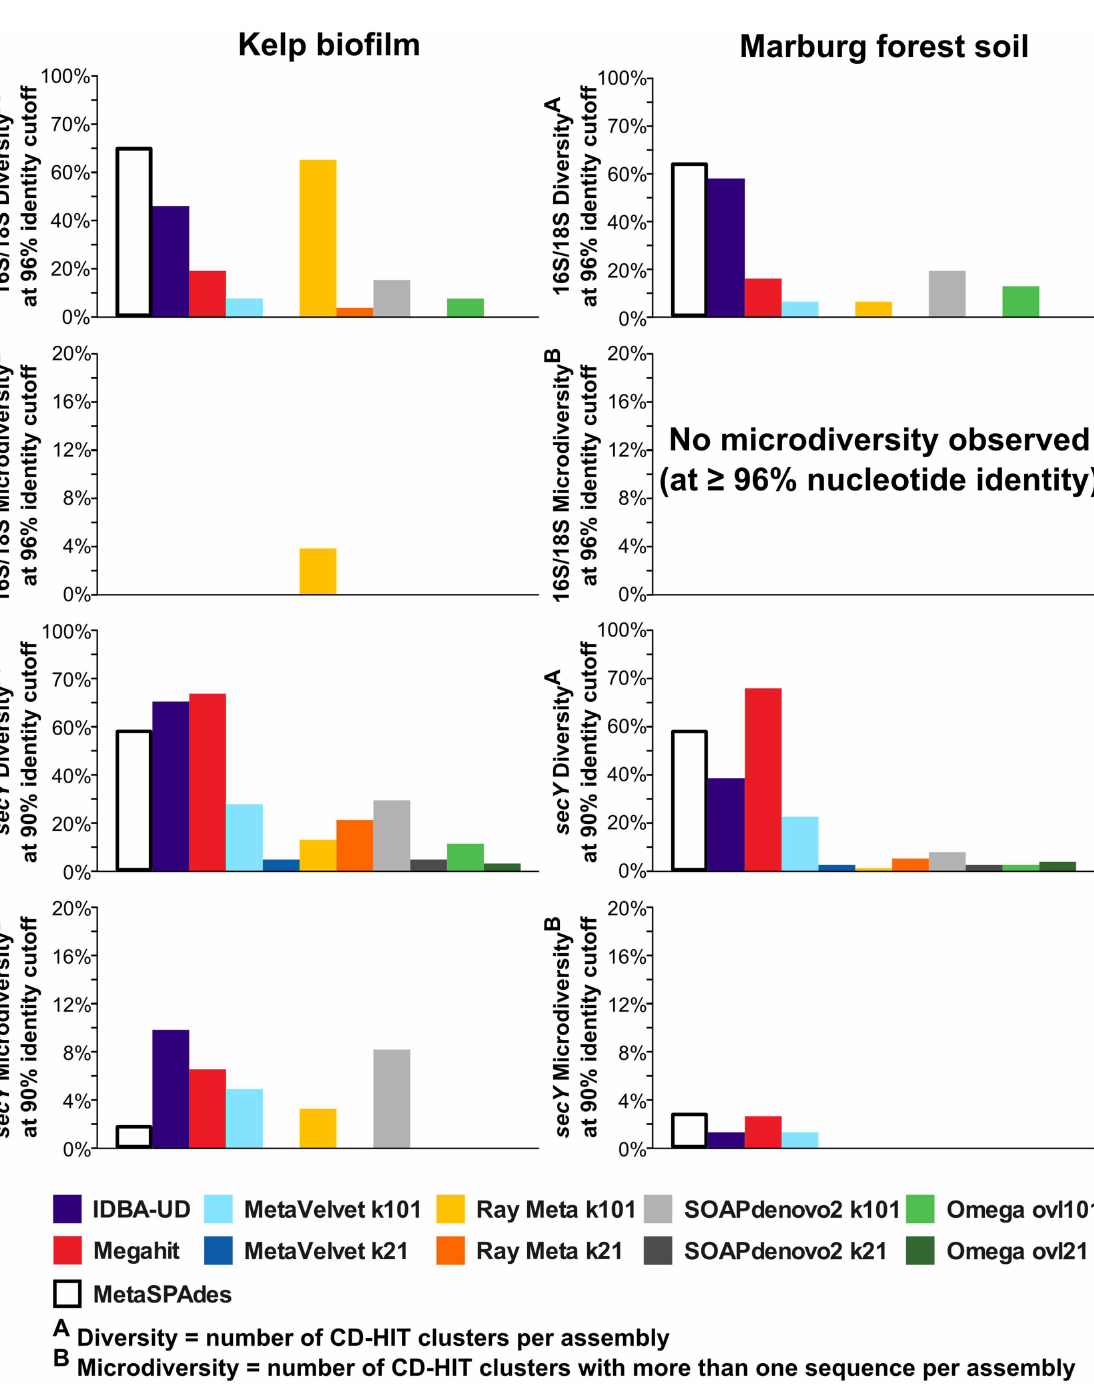
Fig 7. Diversity and micro diversity. Diversity and microdiversity are quantified based on clusterings by CDhit at seqeunce identity cutoffs of 96% (16S/18S rRNA) and 90% (SecY encoding gene sequences). Diversity is representedby the total numberof clusters formed for each assembly. Micro diversity is representedby the number of clusters containing multiple sequences originatingfrom the same assembly.